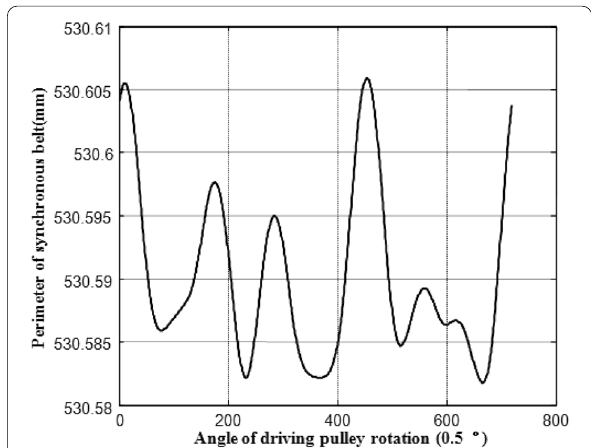
Figure 11 Belt length variation curve after automatic optimization of tension pulley pitch curve